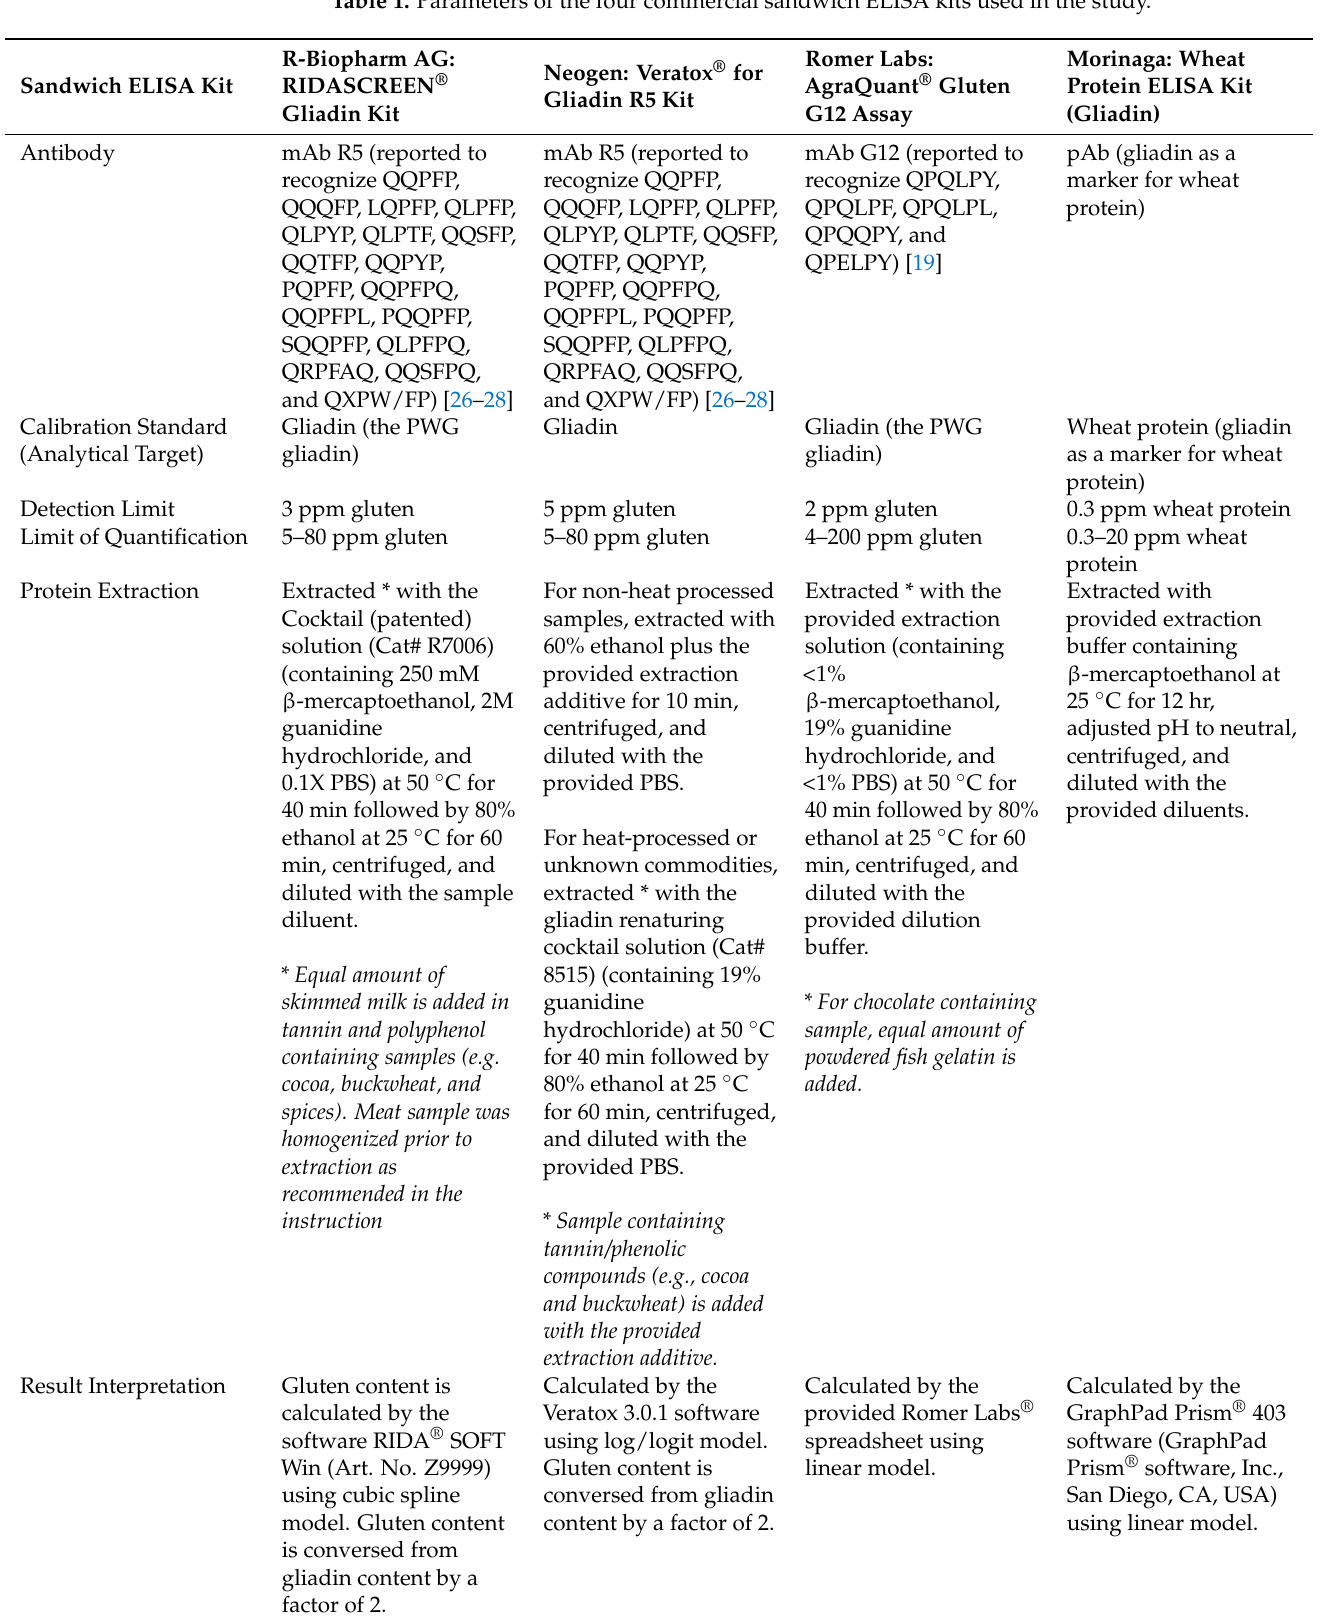
Table 1. Parameters of the four commercial sandwich ELISA kits used in the